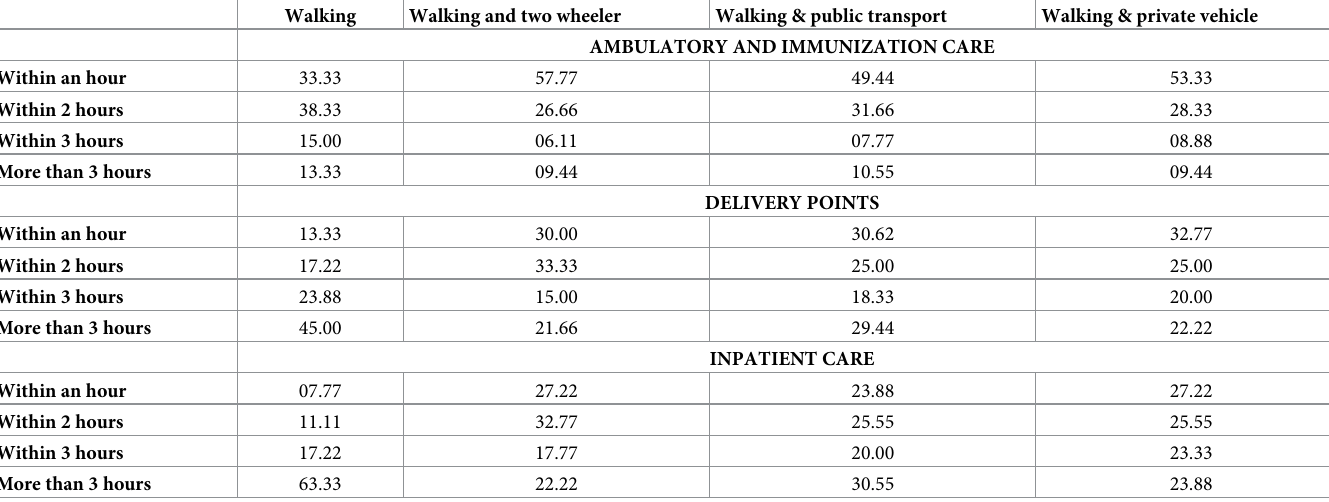
Table 3. Percentage of villages in each travel time catchment by travel